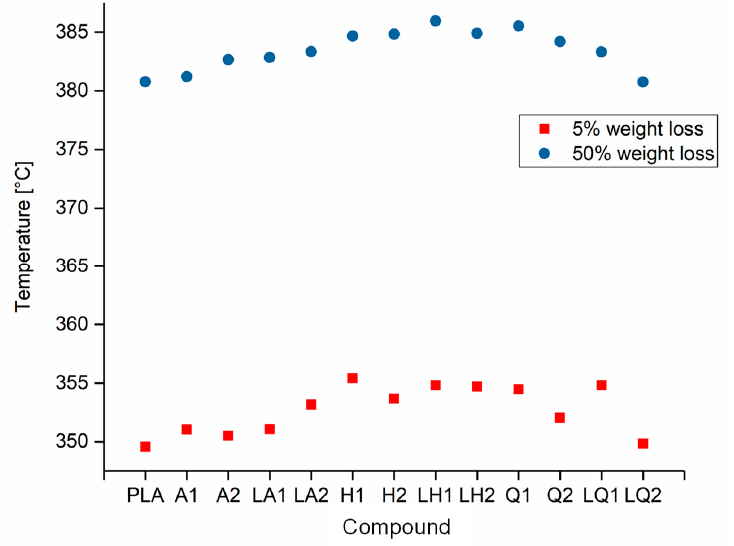
Figure 8. Temperature at 5% and 50% weight loss of PLA and the PLA/dye compounds.